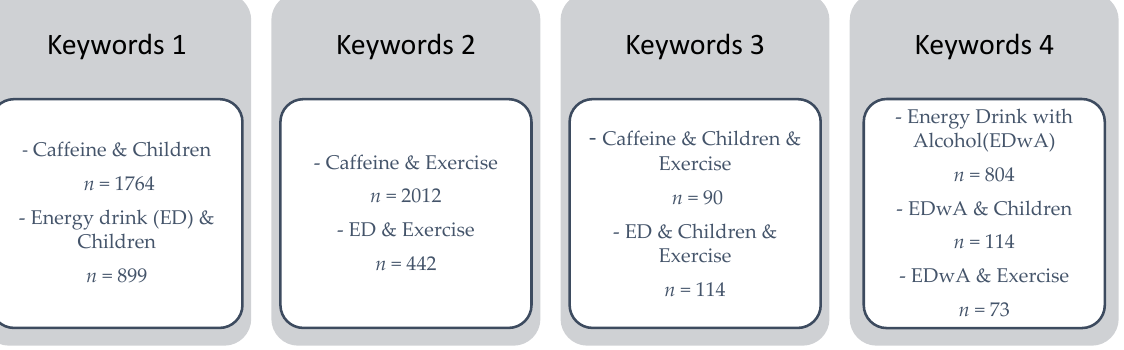
Figure 2. Keywords used when searching data.